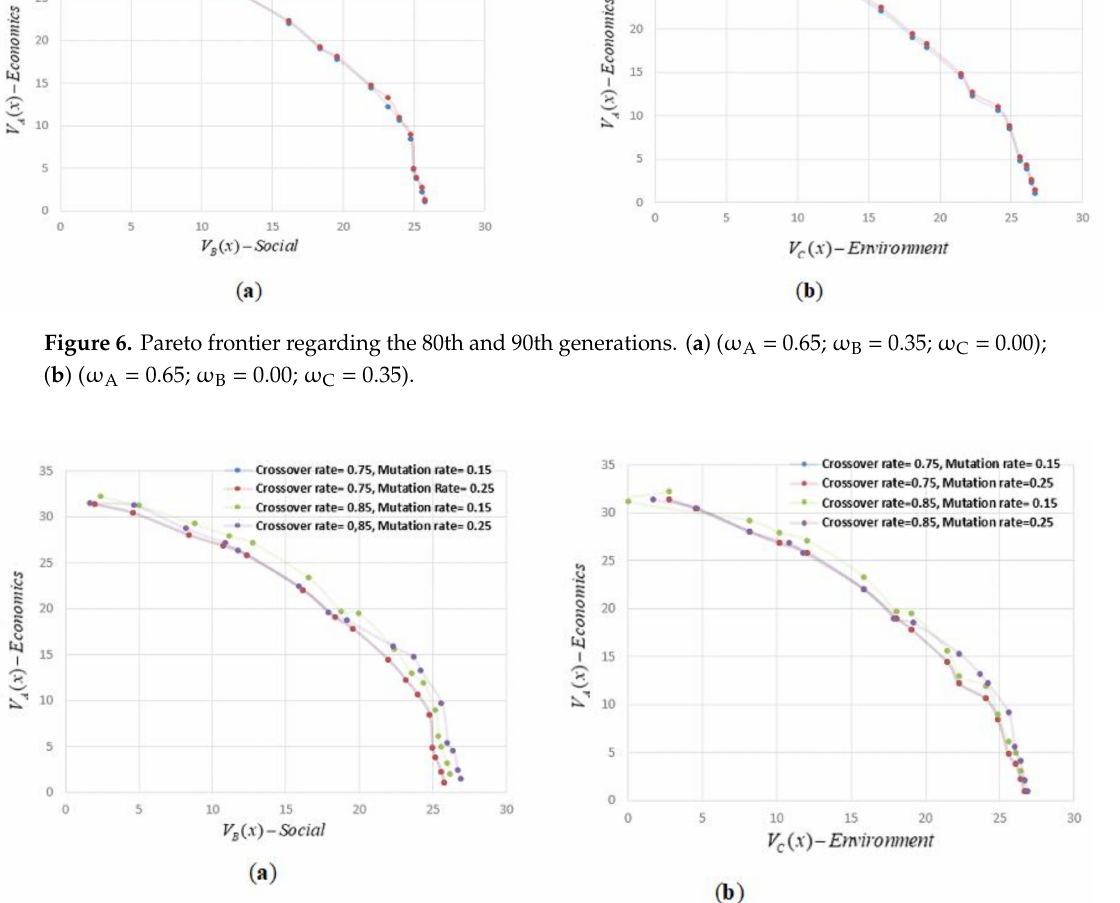
= 0.65; ω = 0.00; ω = A B C